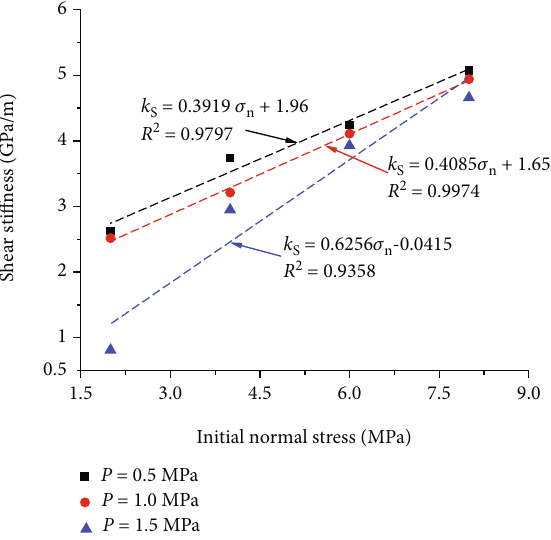
Figure 10: Relationship between the peak dilation rate and initial normal